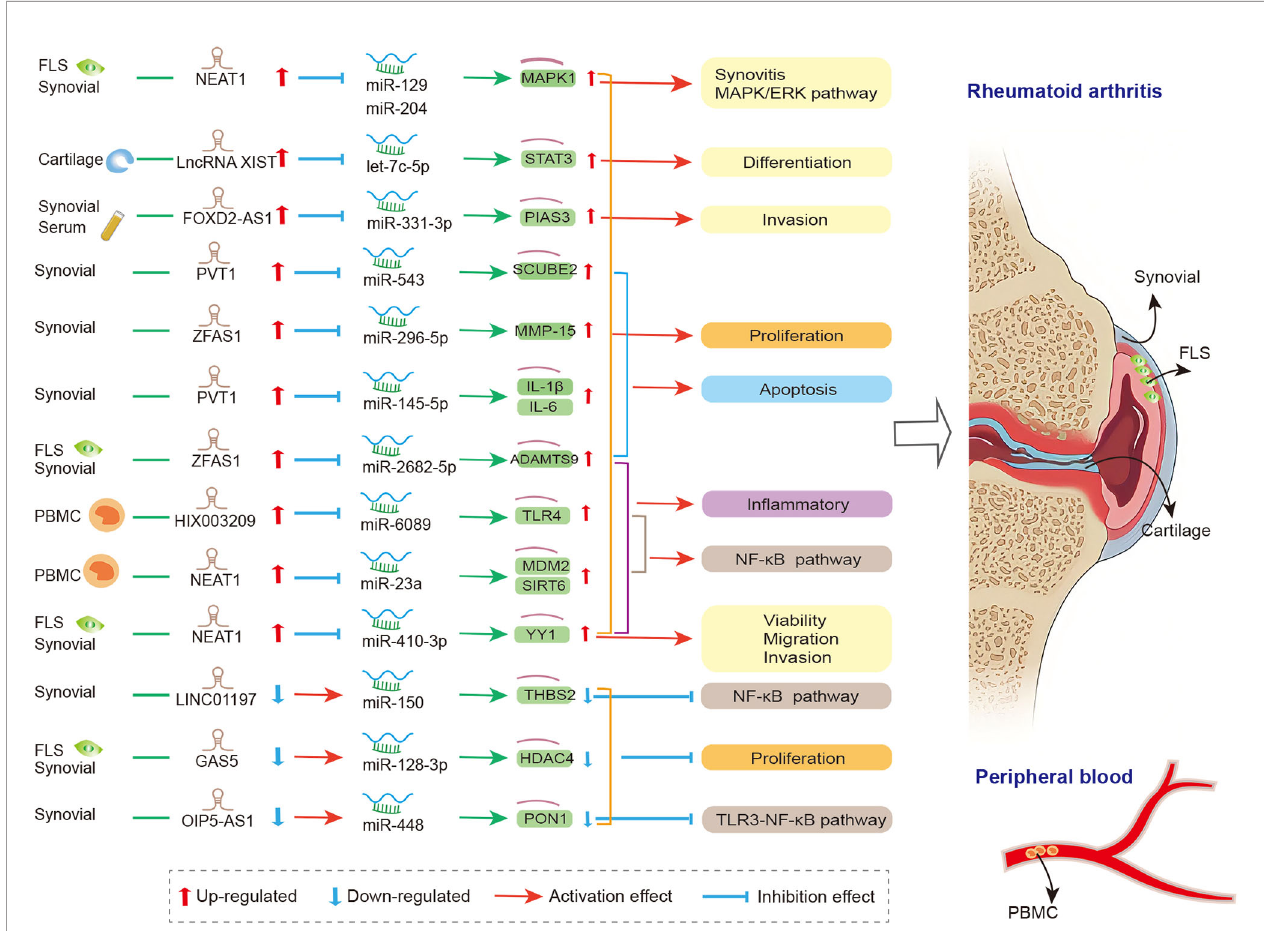
FIGURE 1 | The crosstalk of lncRNA-miRNA-mRNA in RA. FLS, Fibroblast − like synoviocytes; PVT1, plasmacytoma variant translocation 1; SCUBE2, signal peptide- CUB-EGF-like containing protein 2; IL-1 b , interleukin-1 b ; IL-6, interleukin-6; THBS2, thrombospondin-2; GAS5, growth arrest-speci fi c transcript 5; HDAC4, histone deacetylase 4;PIAS3, protein inhibitor of activated STAT3; NEAT1, nuclear paraspeckle assembly transcript 1; MAPK1, mitogen-activated protein kinase 1; YY1, yin yang-1; mdm2, mouse double minute 2; Sirt6, sirtuin 6; PON1, paraoxonase 1; PBMC, peripheral blood mononuclear cell; NEAT1, nuclear paraspeckle assembly transcript 1; MDM2, murine double minute-2; SIRT6, sirtuin 6; MMP-15, matrix metalloproteinase-15; TLR4, toll-like-receptor 4; STAT3, signal transducer and activator of transcription